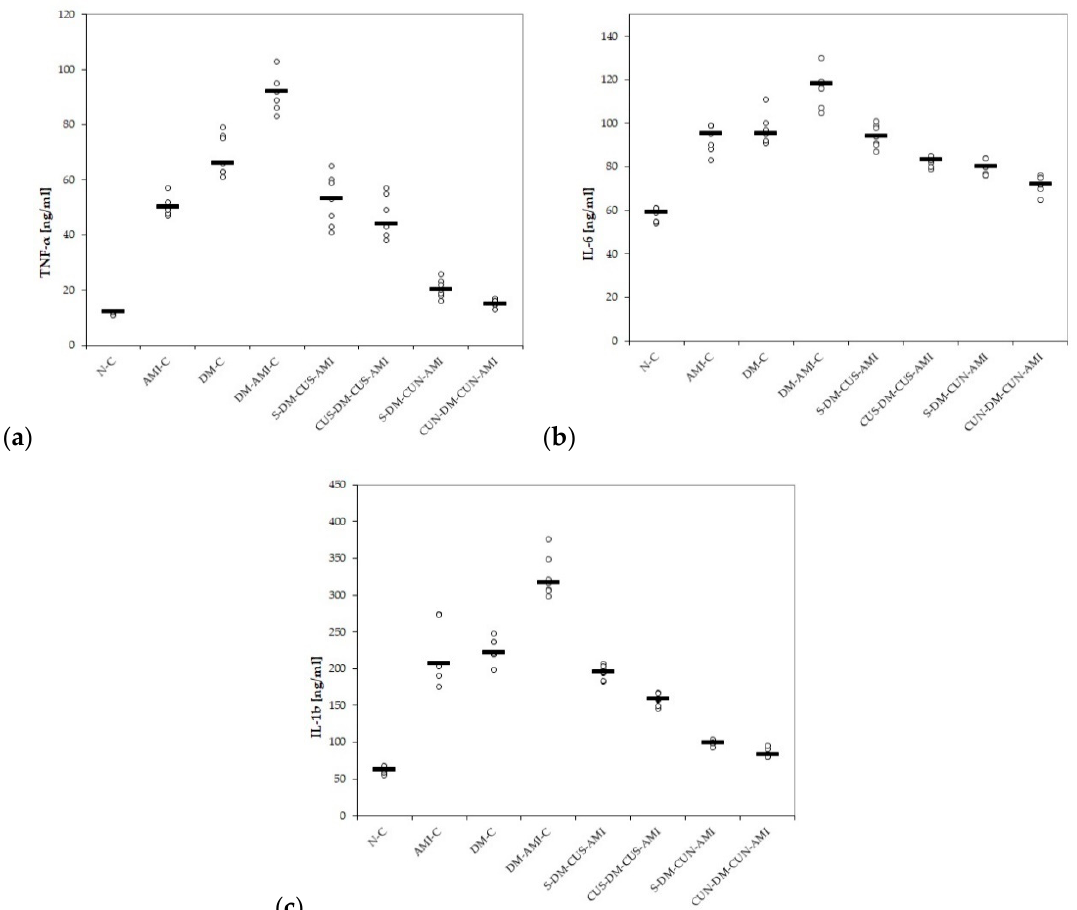
Figure 4. Variation by groups of serum levels of pro-inflammatory cytokines: ( a ) TNF- α (tumor necrosis factor-alpha), ( b ) IL-6 (interleukin 6), and ( c ) IL-1 β (interleukin 1 β ), by groups. Notes: The circles represent the individual values, and the horizontal line is given by the median. Abbreviations: N = normal; C = control; AMI = acute myocardial infarction; DM = diabetes mellitus; S = saline; CUS = curcumin solution in a dose of 200 mg / kg bw; CUN200 = curcumin nanoparticles solution in a dose of 200 mg / kg Table 9. P -values for comparisons between the study groups for pro-inflammatory cytokine.